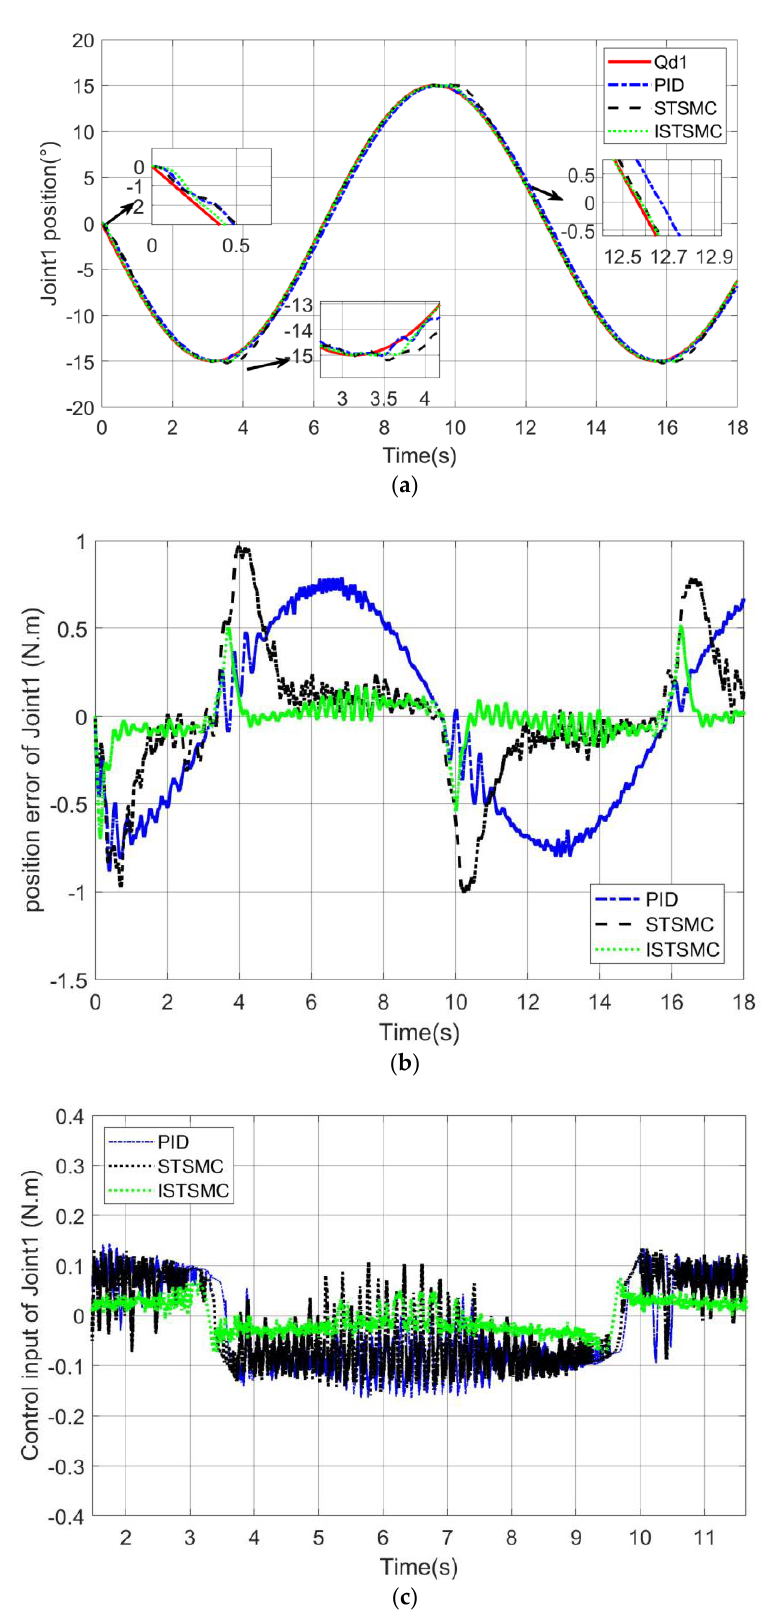
Figure 6. Joint 1 under sine. ( a ) Trajectory tracking diagram; ( b ) trajectory tracking error diagram; ( c ) control input